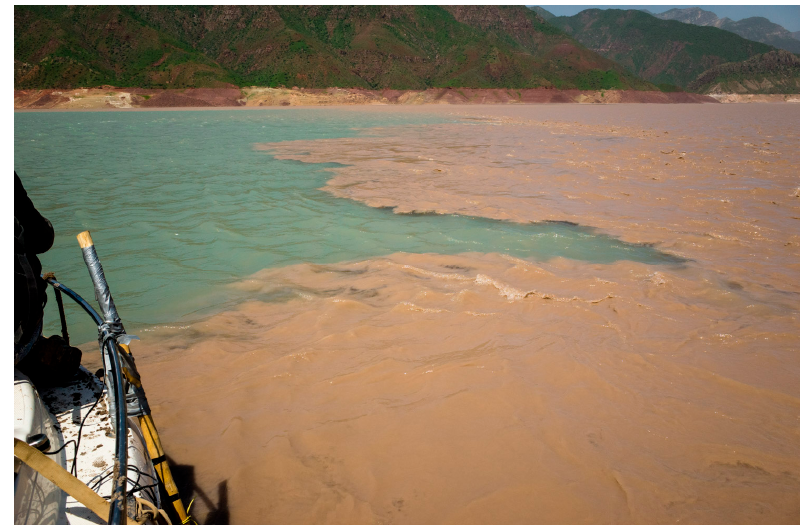
Figure 8. Photograph of the plunge line for a turbid density current entering Nurek reservoir on Vakhsh River, Tajikistan. Flow is toward the left. (photo by author).